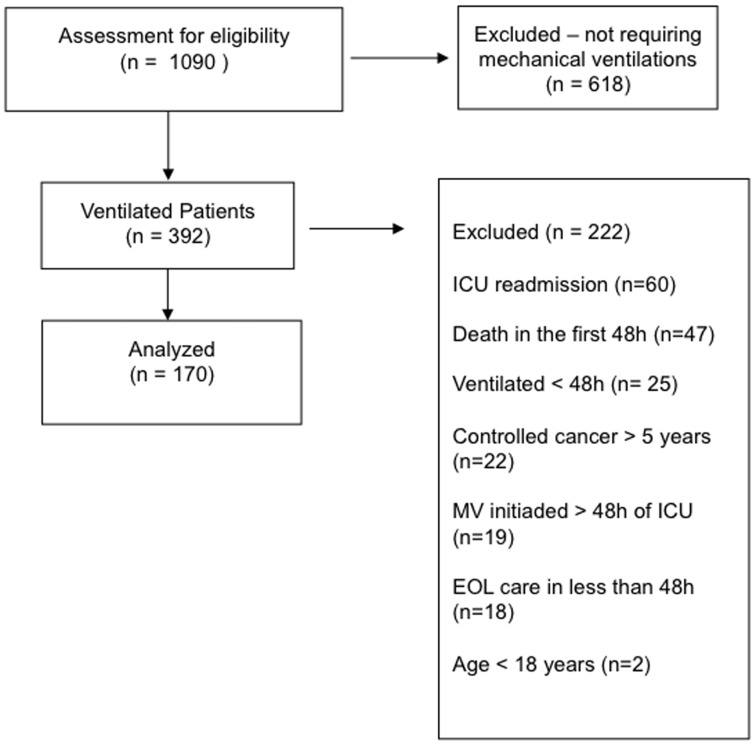
Study Flow Diagram.